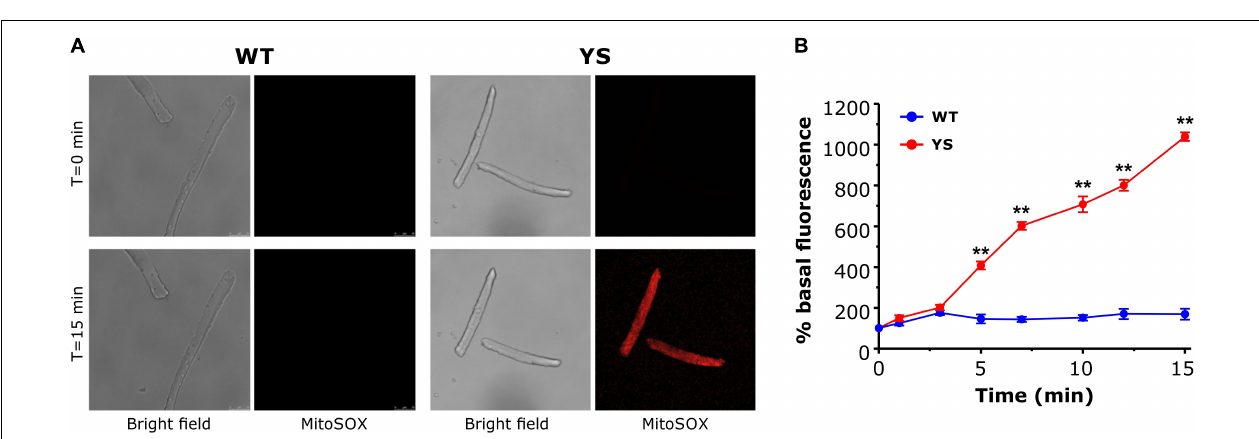
FIGURE 6 | Mitochondrial ROS production in the presence of 20 mM caffeine as determined by MitoSox Red. (A) Representative bright field and Mitosox Red fluorescence images of single FDB fibers exposed to 20 mM caffeine at T = 0 and T = 15 min. (B) Average variations of MitoSox Red signal during exposure to 20 mM caffeine. Caffeine was added in one shot at T = 0. Data are shown as means ± SEM. ∗∗ p < 0.01. n = 5 WT and 5 YS